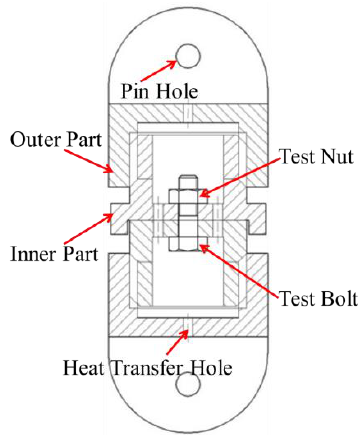
Figure 1. Schematic diagram of the installation of the fixture device.